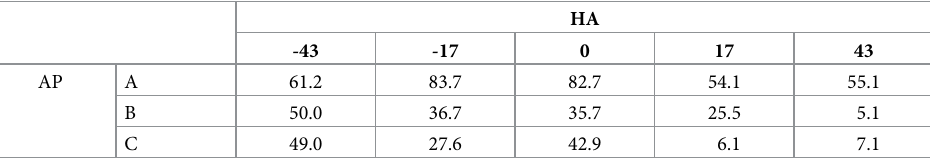
Table 2. Percentage of participants that judged each posture as won a game in Experiment 2.